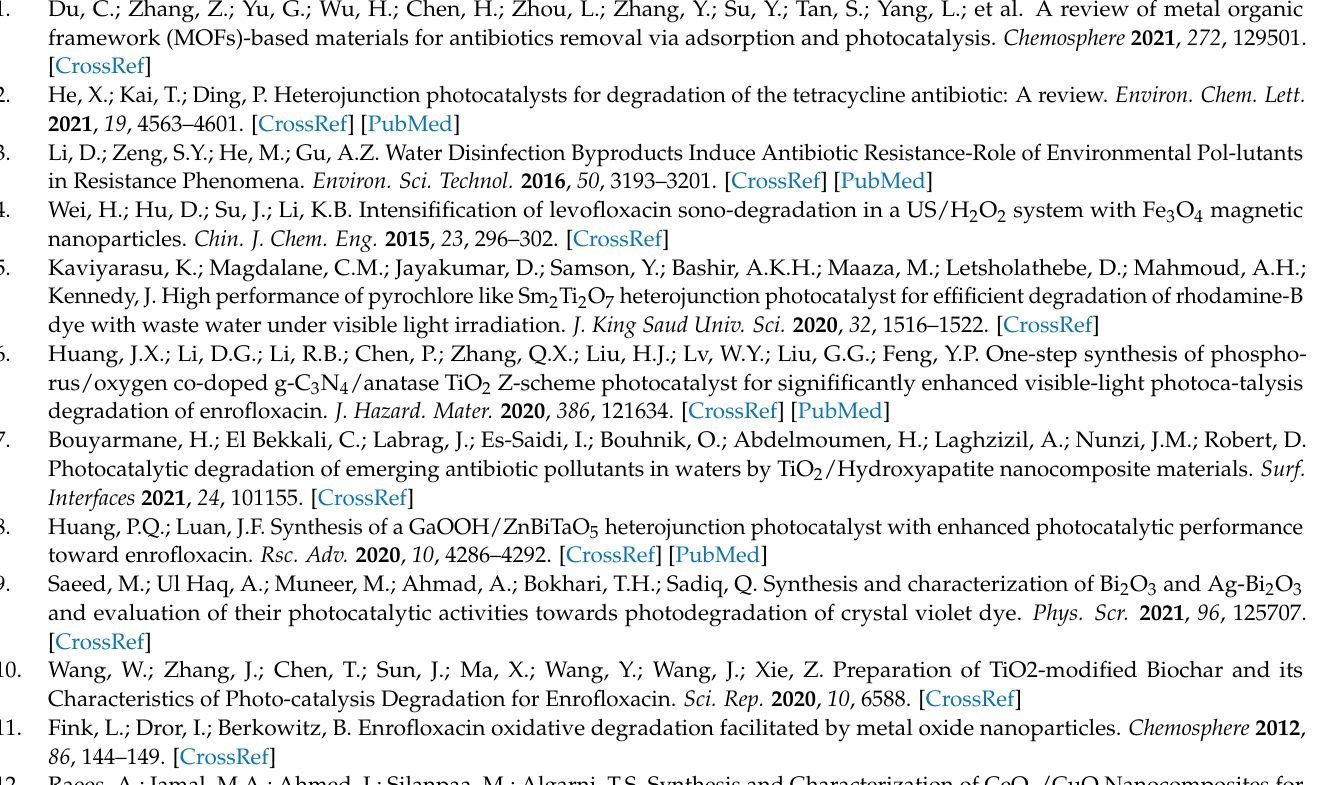
Figure S3: The X-ray diffraction pattern of Er 2 FeSbO 7 /BiTiSbO 6 heterojunction after the reaction; Figure S4: ( a ) UV-Vis diffuse reflectance spectra of BiTiSbO 6 ; ( b ) Plot of ( α h ν ) 2 versus h ν for BiTiSbO 6 . Figure S5: Observed first-order kinetic plots for the PCD of ENR with EBH as photocatalyst under VLGI for three cycle degradation